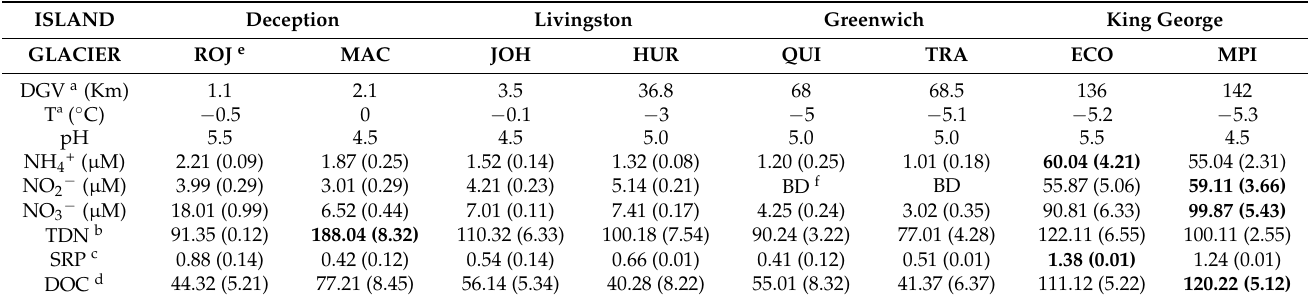
Table 2. Geochemical properties and chemical analysis of soluble nutrients in the meltwater. ISLAND Deception Livingston Greenwich King George